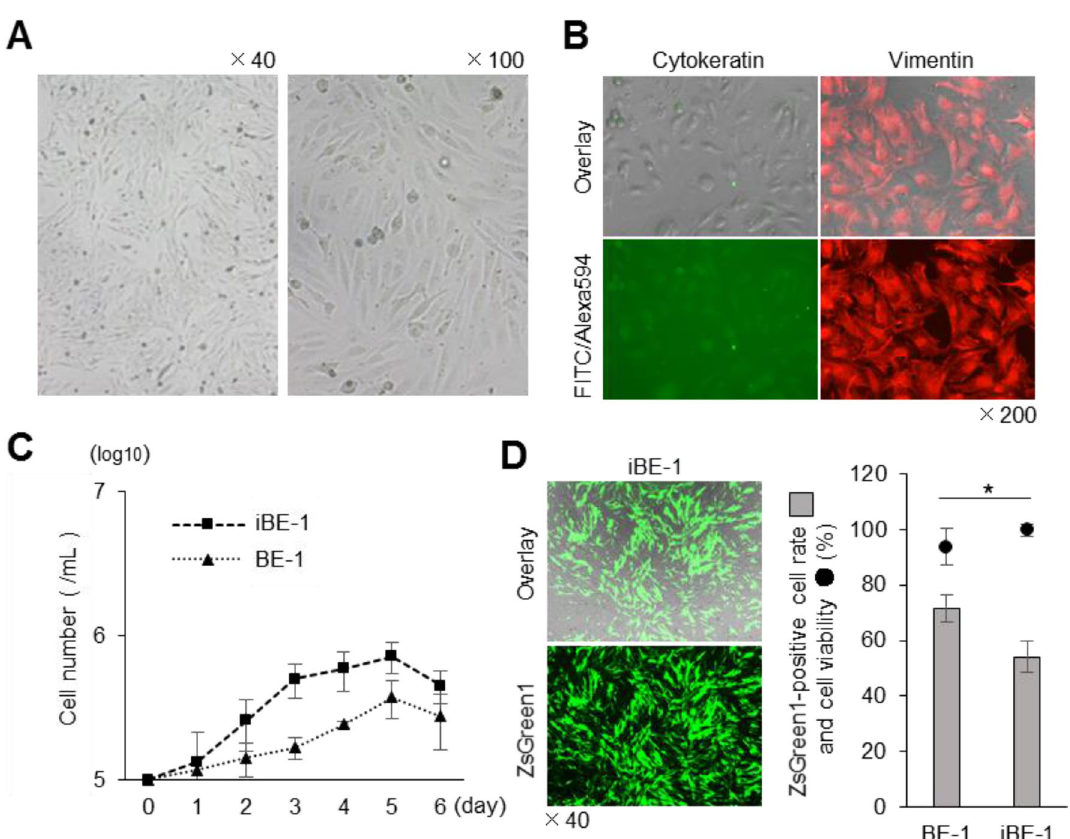
Figure 3. Characterisation of artificially immortalised iBE-1 cells. ( A ) Pictures of iBE-1 cells from P.9–1. ( B ) IFA was performed to investigate the constituent cells in iBE-1 cells (P.9–25). ( C ) The growth kinetics for iBE-1 cells (P.9–25) were compared with those for BE-1 cells (P.20). These cultured cells were seeded at a concentration of 1 × 10 5 cells/well, and the number of cells was counted every 24 h for 6 days. ( D ) ZsGreen1-expression vector (250 ng/well) was transfected into iBE-1 cells (P.9–36), using the TransFectin Lipid Reagent, and the ZsGreen1- positive cell rate and cell viability were measured at 48 hpt. The lipofection efficiency and cell viability of BE-1 cells is shown in Fig. 1A. Asterisks indicate significant differences between BE-1 and iBE-1 cells (* P <